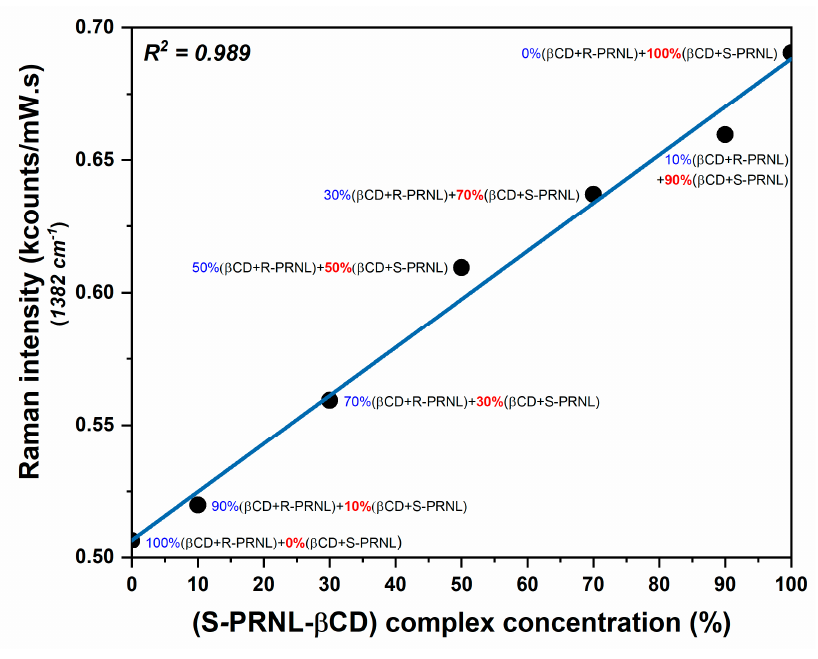
Figure 6. Intensity variation of the most prominent vibrational band (1382 cm − 1 ) as a function of S-PRNL/ β CD concentration. The intensity values were taken from the spectra presented in Figure 5.